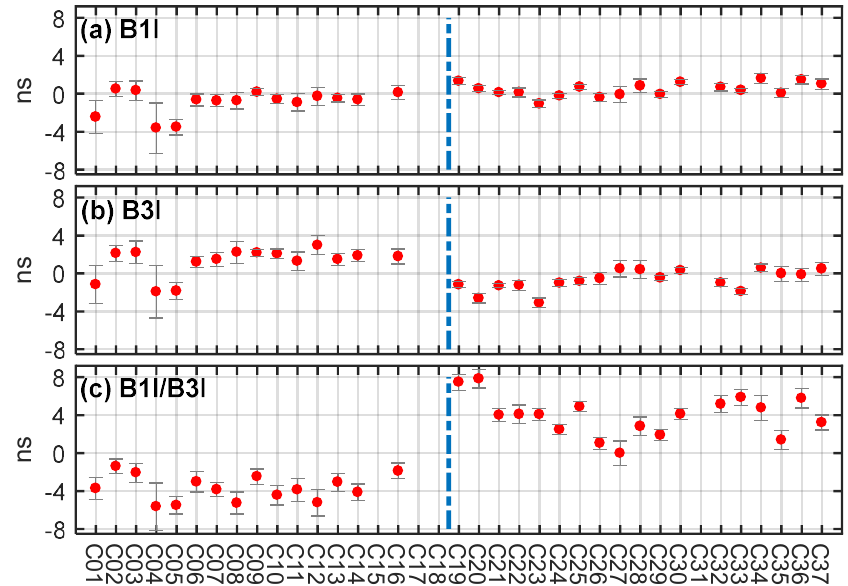
Figure 3. Averaged weekly α · R − Clk bias at B1I ( a ), B3I ( b ), and B1I / B3I ( c ) frequencies. The error bar stands for the standard deviation of the bias from GPS weeks 2035–2059. The BDS-2 and BDS-3 satellites are separated by the dashed line.